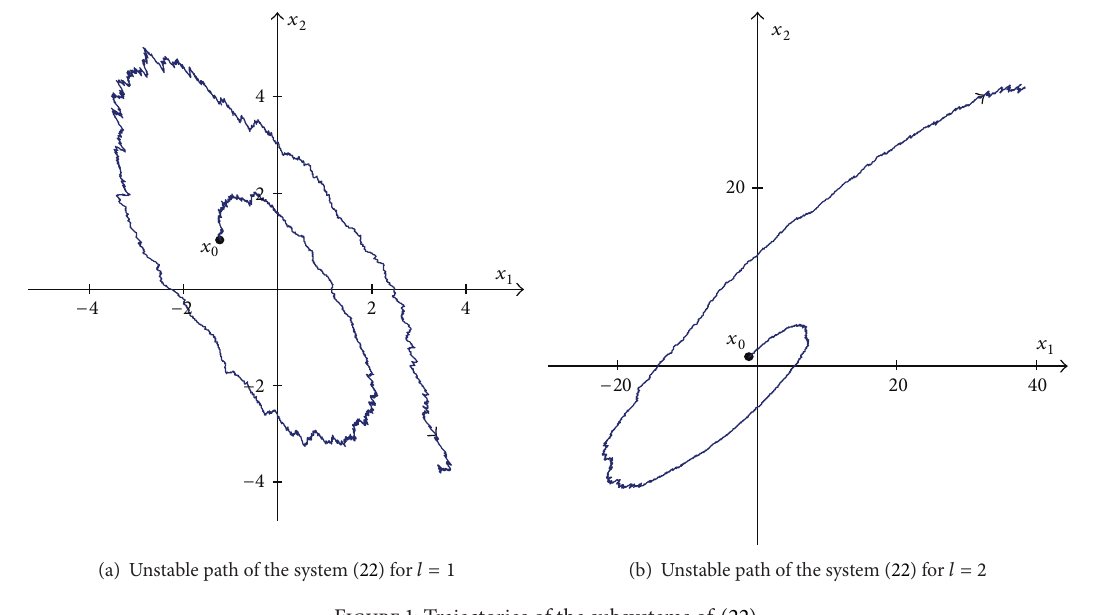
Figure 1: Trajectories of the subsystems of (22).